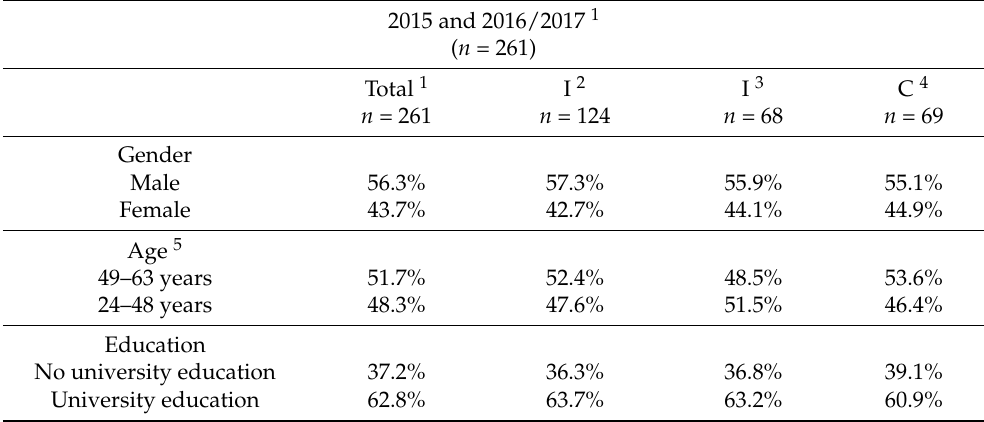
Table 1. Percentages of subordinates by gender, age, and education for the intervention and control groups, n =